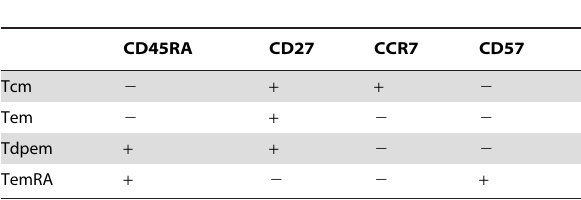
Table 2. Memory T cells subsets and their surface phenotype.